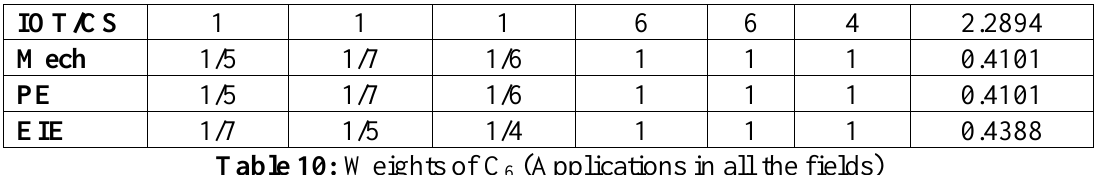
Table 10: Weights of C